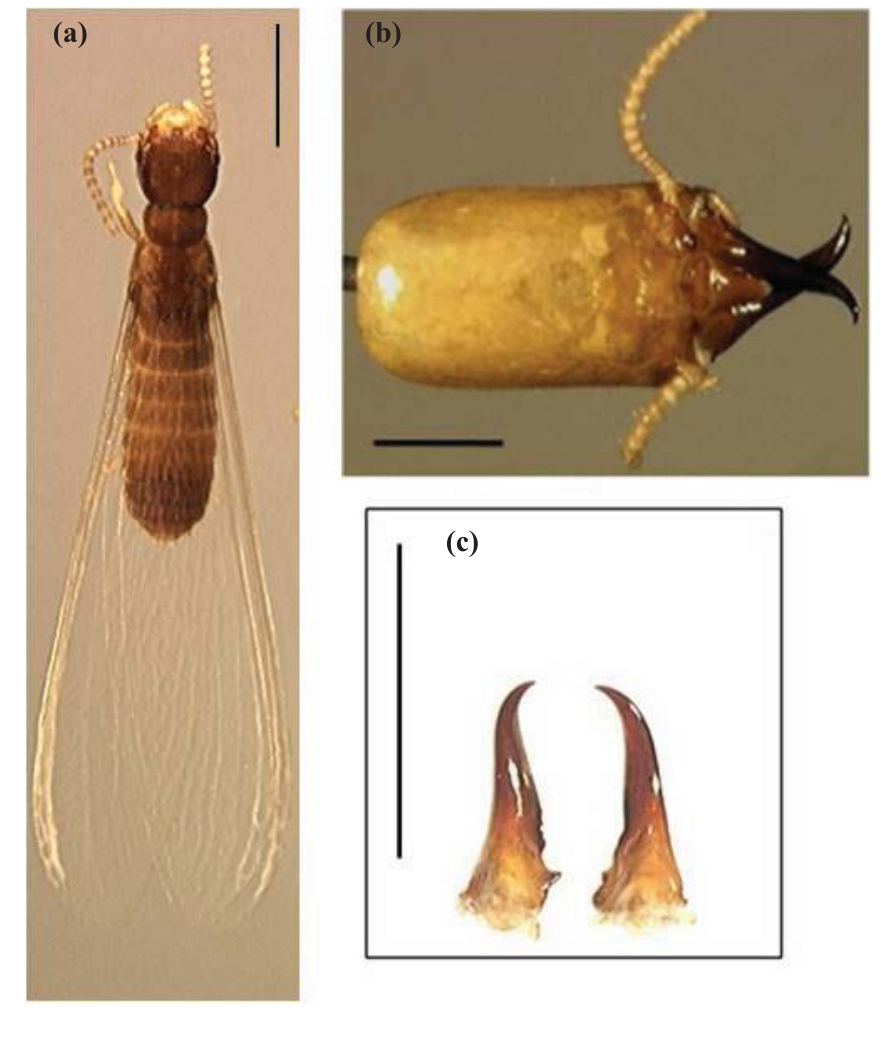
Figure 8. Reticulitermes nelsonae, diagnostic morphological characters for species identification: ( a ) Alate, dorsal, scale bar = 1.0 mm, ( b ) Soldier head capsule, dorsal,